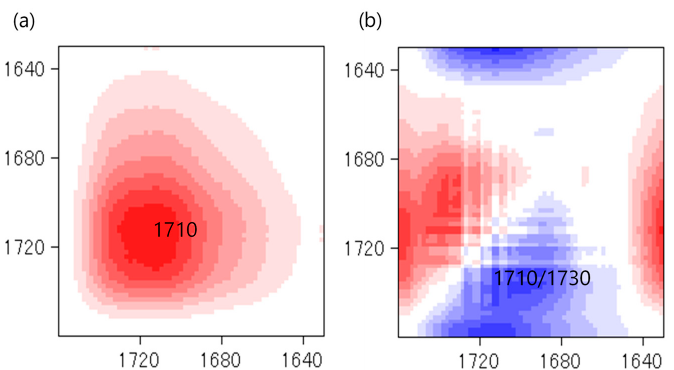
Figure 7. Synchronous ( a ) and asynchronous ( b ) spectra in carbonyl region at different NCO/OH ratios.